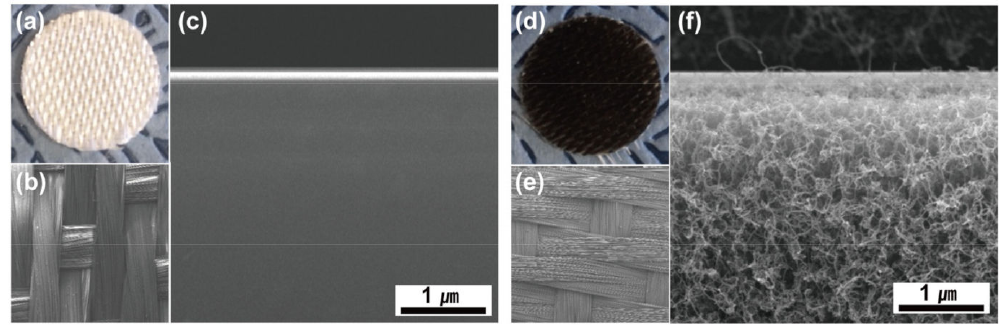
Figure 2. ( a ) Optical image of the pristine QWF (P-QWF) electrode. SEM images of the P-QWF electrode; ( b ) Top view at low magnification; ( c ) Cross-sectional view; ( d ) Optical image of the copper nanotube (CNT)-coated QWF electrode (C-QWF) electrode. SEM images of the C-QWF electrode; ( e ) Top view at low magnification; ( f ) Cross-sectional view.